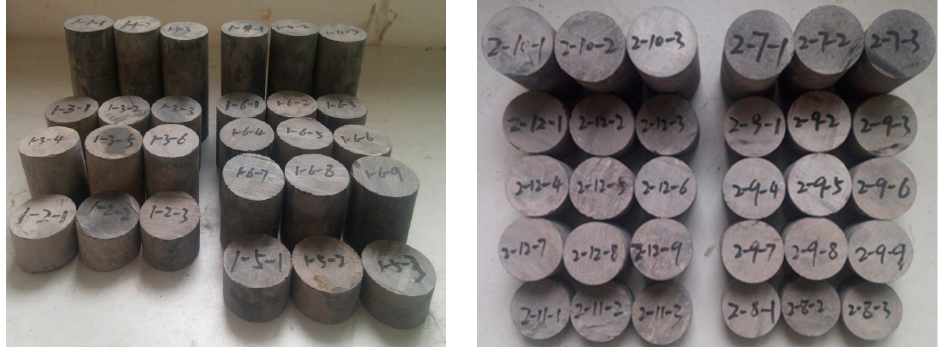
Figure 2. Example of sample in the experimental part. (1) Uniaxial compression and deformation experiments on coal rock masses were con- ducted to measure the uniaxial compressive strength, elastic modulus, and Poisson’s ratio of coal rock masses. Before the measurement, the strain gauges attached to the specimens were connected to the resistance strain gauge and the half-bridge circuit was used to measure the transverse and longitudinal directions of the specimens during loading. Some examples of the field experiment are shown in Figure 3.